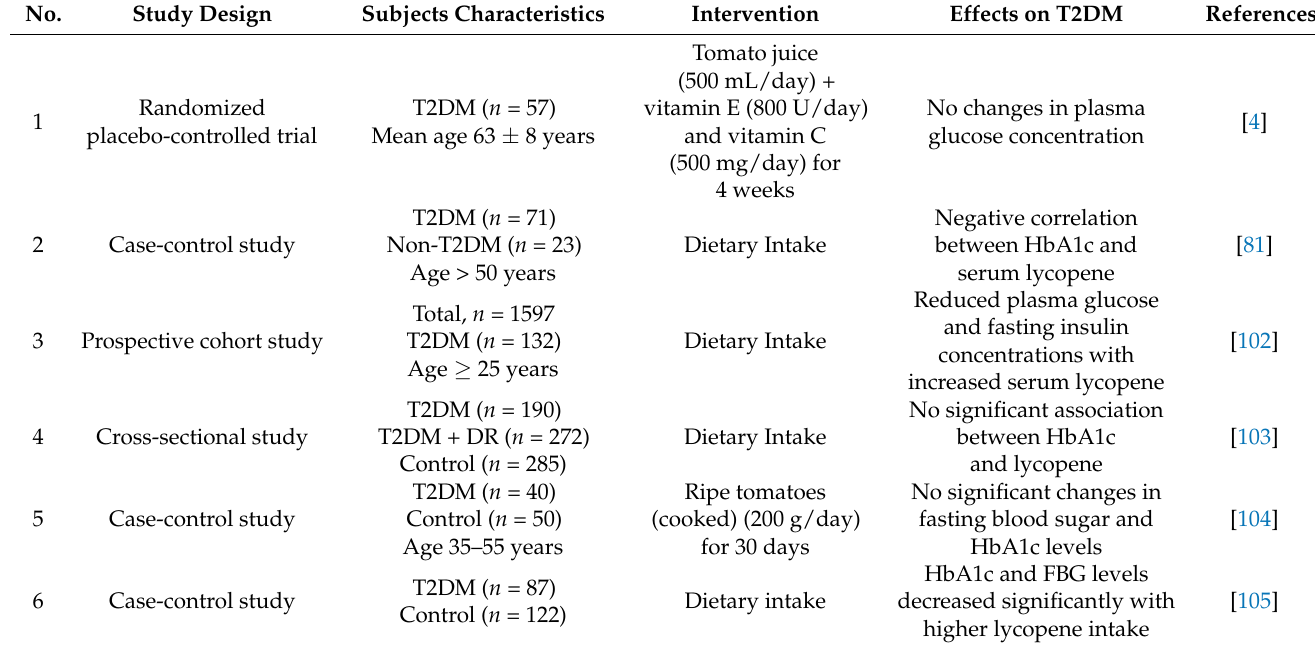
Table 6. Effect of lycopene on glycemic control in T2DM (Human